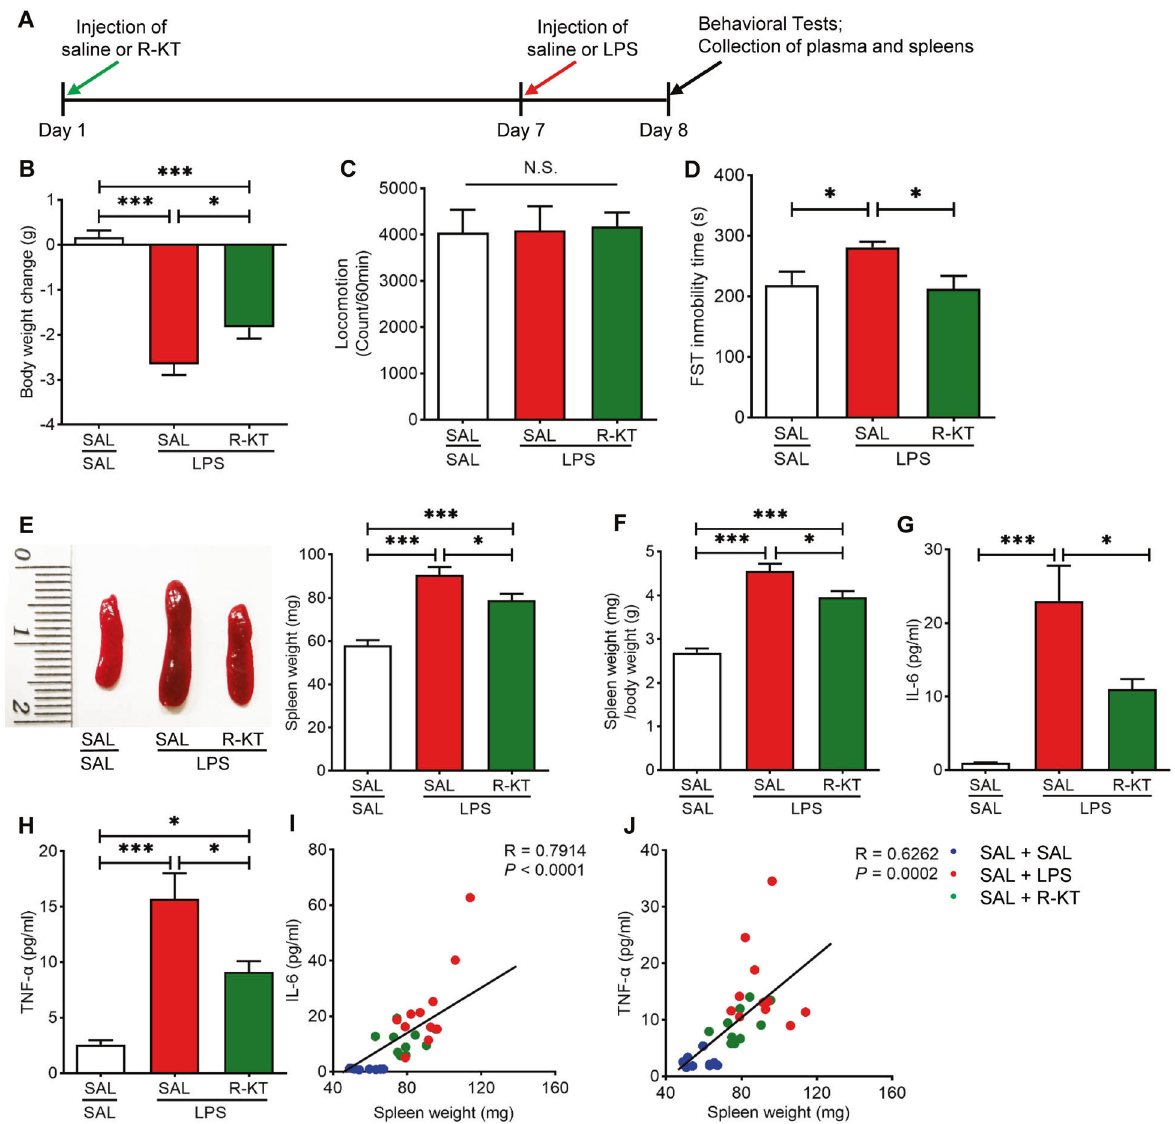
Fig. 1 Prophylactic effects of ( R )-ketamine on depression-like phenotype, splenomegaly and in fl ammatory cytokines after LPS injection. A Treatment schedule. Adult mice were intraperitoneally (i.p.) injected with lipopolysaccharides (LPS, 1.0 mg/kg) or saline (10 ml/kg). ( R )- ketamine (10 mg/kg) or saline (10 ml/kg) was i.p. injected to mice 6 days before LPS injection. Locomotion test and forced swimming test (FST) were performed 23 and 24 h after the injection of saline or LPS. Blood and spleens were collected after behavioral tests. B Body weight change (one way ANOVA: F 2,24 = 41.19, P < 0.0001). C Locomotion test (one way ANOVA: F 2,24 = 0.034, P = 0.966). D FST (one way ANOVA: F 2,24 = 4.738, P = 0.018). E Representative picture of spleen and spleen weight (one way ANOVA: F 2,27 = 27.06, P < 0.001). F The ratio of spleen